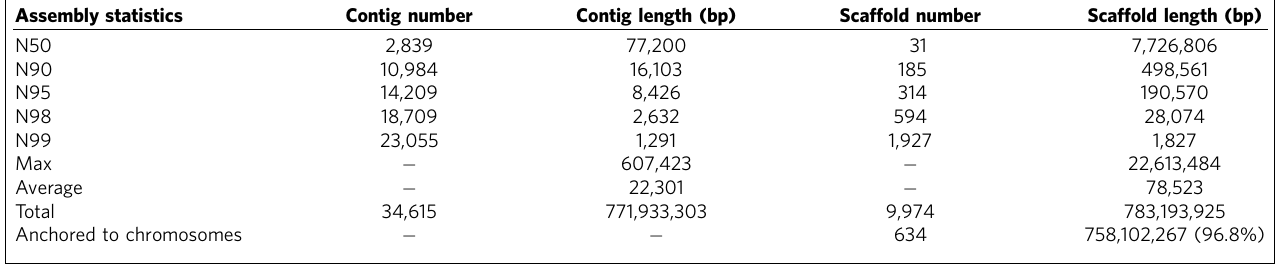
Table 1 | Summary statistics of the channel catfish reference genome assembly. Assembly statistics